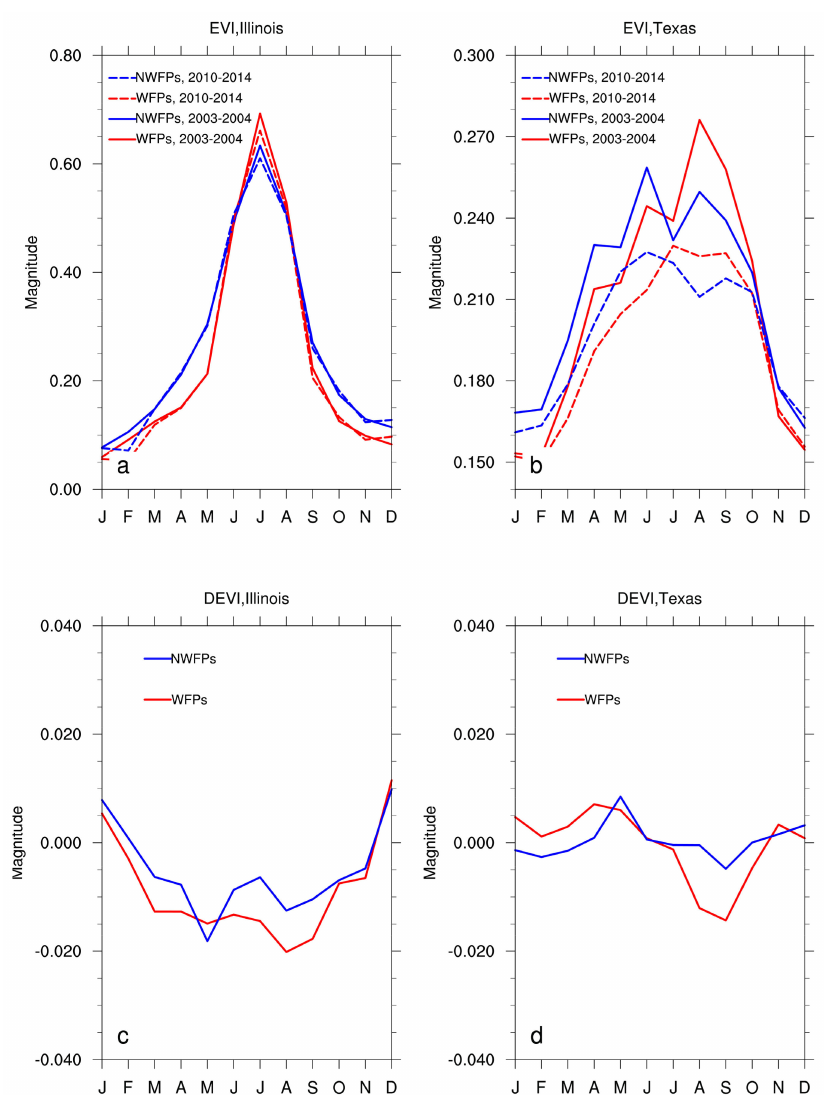
Figure 9. The seasonal cycle of the monthly mean EVI for the pre- (2003–2004, solid) and post- (2010–2014, dashed) turbine periods and DEVI (2010–2014 averages minus 2003–2004 averages) averaged over WFPs (red) and NWFPs (blue): ( a ) EVI in Illinois, ( b ) EVI in Texas, ( c ) DEVI in Illinois, and ( d ) DEVI in